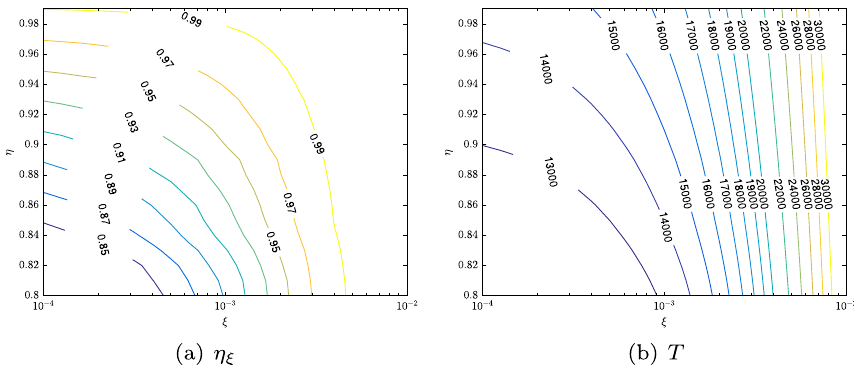
Fig. 10 Comparison of the contour maps of η ξ and T under n = 150 . The figure shows comparison of the contour maps of η ξ and T under n = 150 . We can see that in order to achieve the same value of η ξ with different transmission number, which indicates the existence of the smallest transmission number and the corresponding optimal values of ω and ξ to fulfill the near-broadcast requirement of mobile edge